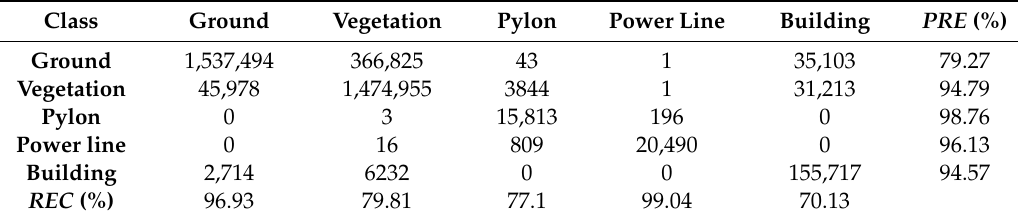
Table 6. The confusion matrix and performance measures of site II (classifier = RF, feature set = F 0 , class distribution = unbalanced, R = 1.5 m).